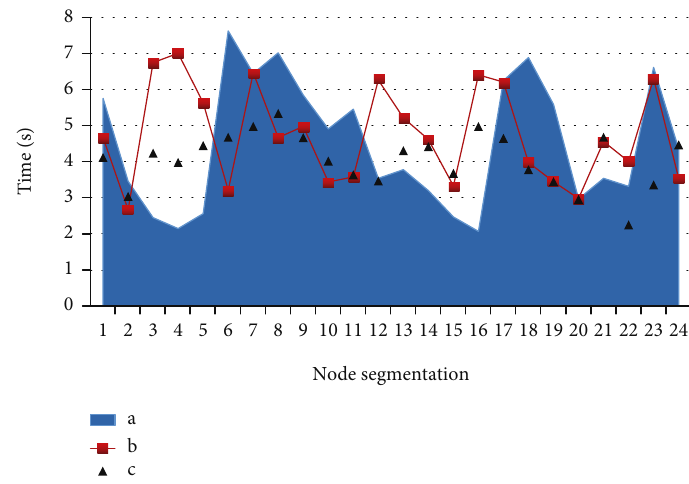
Figure 9: Time-consuming robot fi xed-point path trajectory optimized by di ff erent